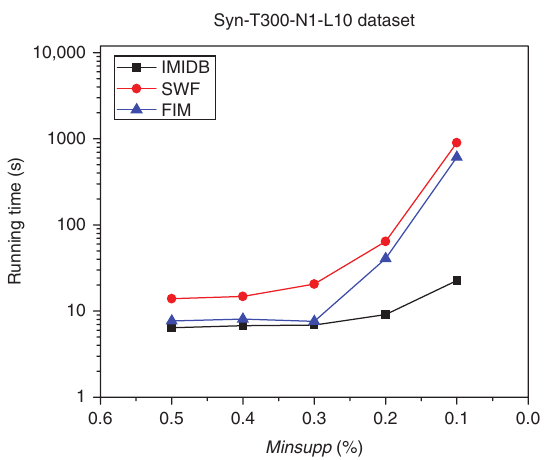
Figure 11: Running Time Comparison – Syn-T300,N1,L10